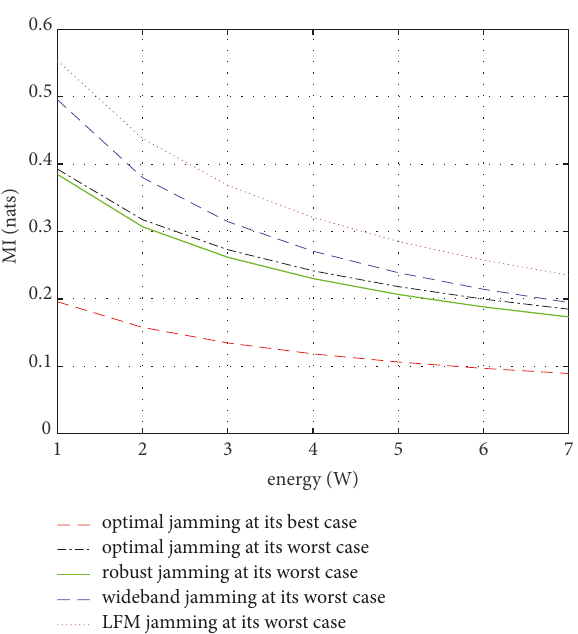
Figure 9: MI performance of the jamming results for single